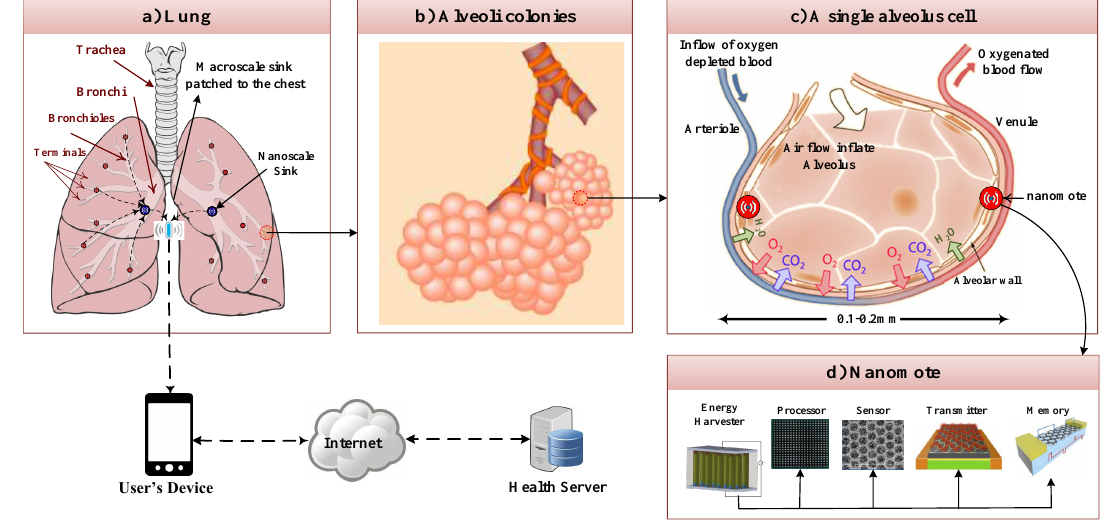
Figure 1: A schematic architecture of the proposed lung monitoring system via